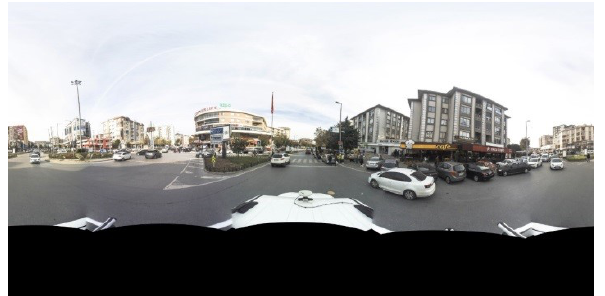
Figure 17: Sample panorama from a Istanbul street